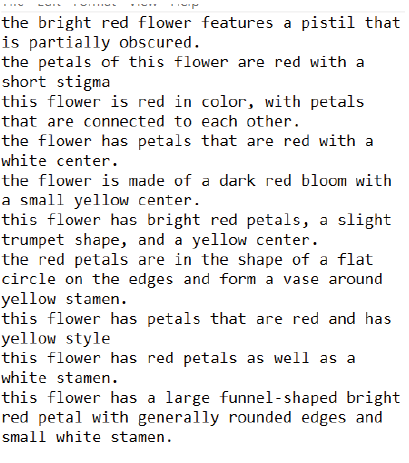
Fig. 6. Text description